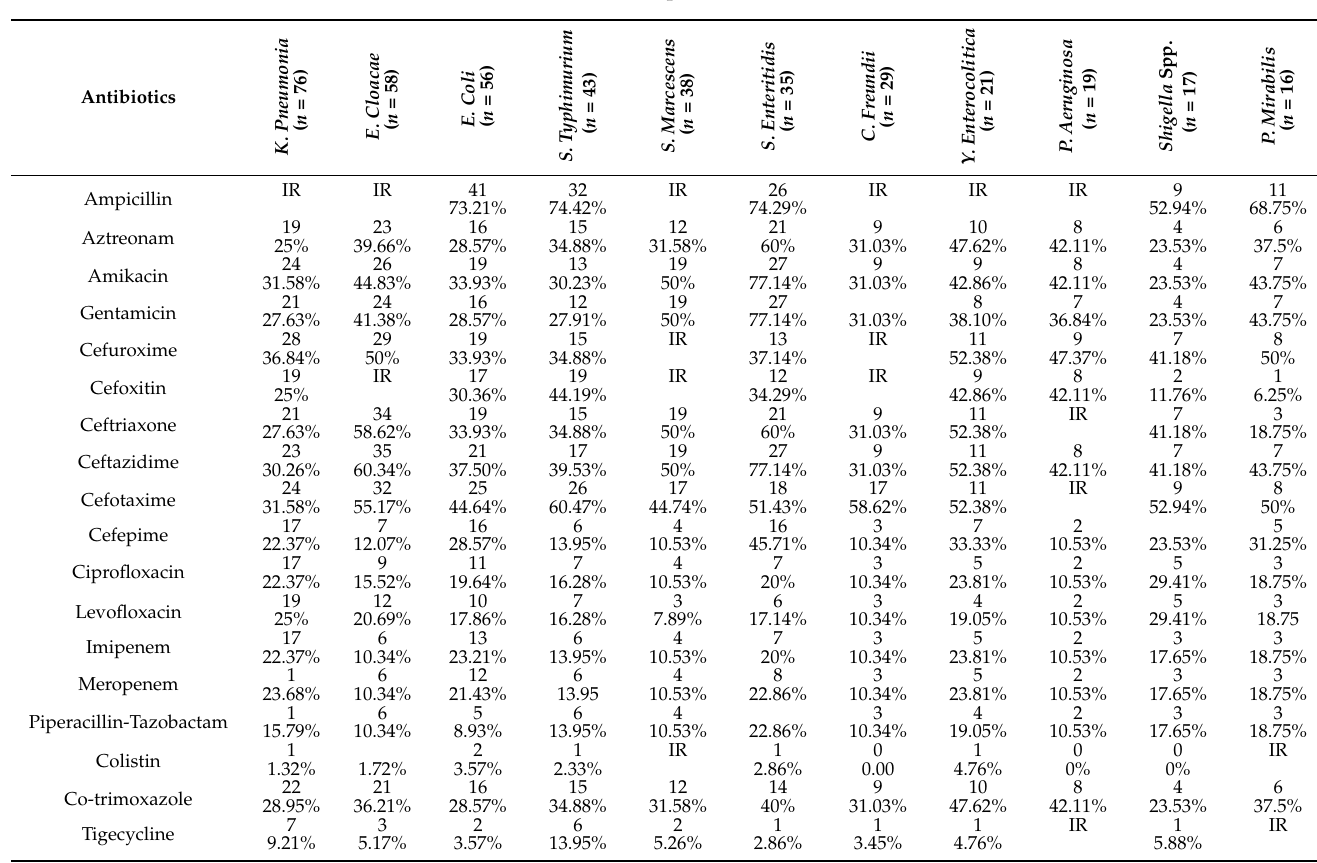
Table 2. Antimicrobial resistance profiles of food isolates ( n =